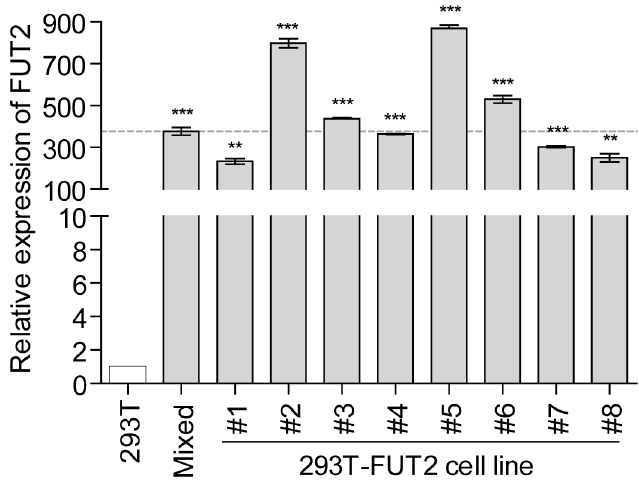
Figure 1. Expression of α 1,2-fucosyltransferase 2 ( FUT2 ) in 293T-FUT2 cells. Total RNAs from cells of wild-type 293T, mixed-cell population, and 293T-FUT2 cell lines were extracted and analyzed for FUT2 expression. The expression in wild-type 293T cells was set to 1 and used as the calibrator. Data are the means ± standard deviation (SD) of triplicate experiments. Mixed, mixed-cell population. Statistical significance was determined by the Student’s t -test using GraphPad Prism version 5, and values are indicated as follows: ** p < 0.01; *** p < 0.001.